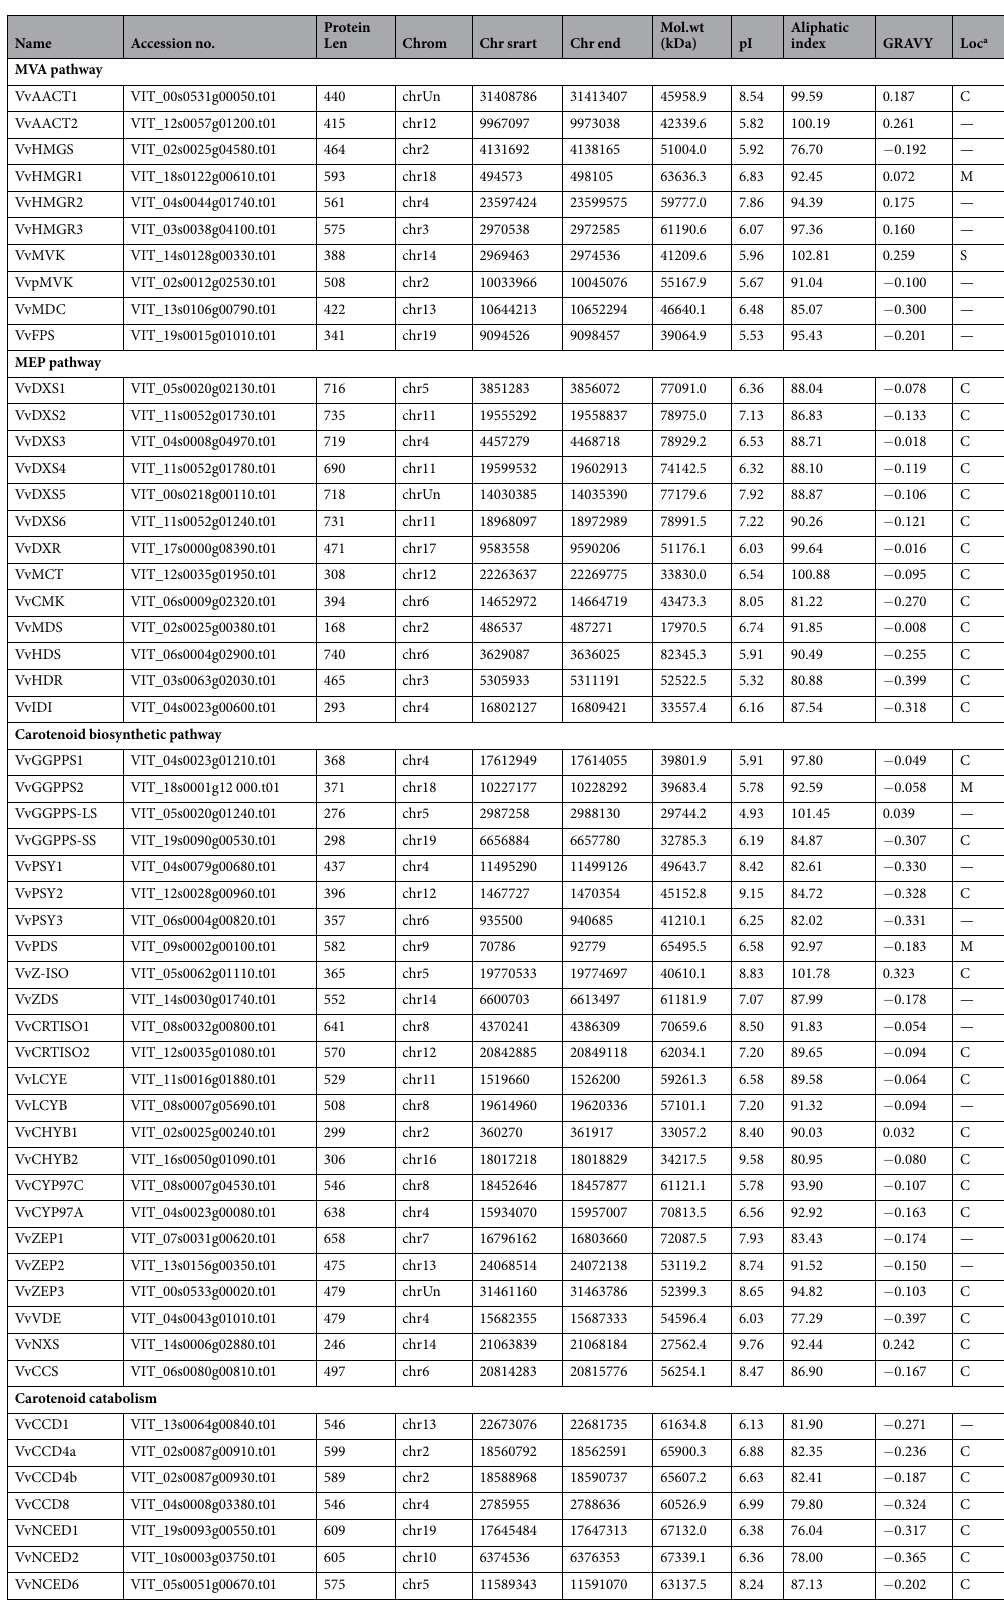
Table 1. Carotenoid metabolic genes in grapevine. a The subcellular location result of grapevine